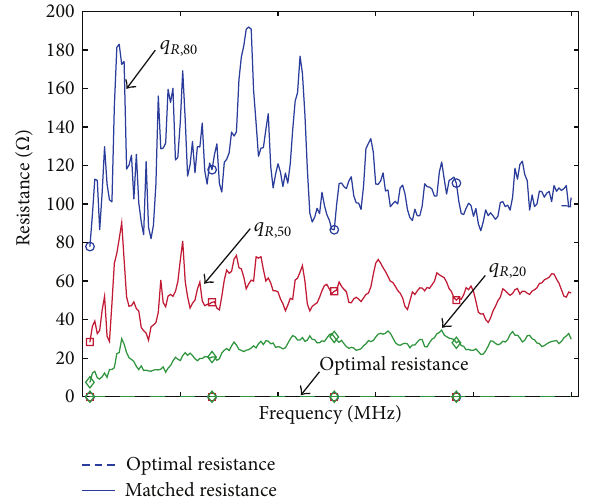
Figure 6: Quantiles of the resistive component of the optimal and power matched receiver impedance. Three probability values are considered, that is, 20, 50, and 80%.